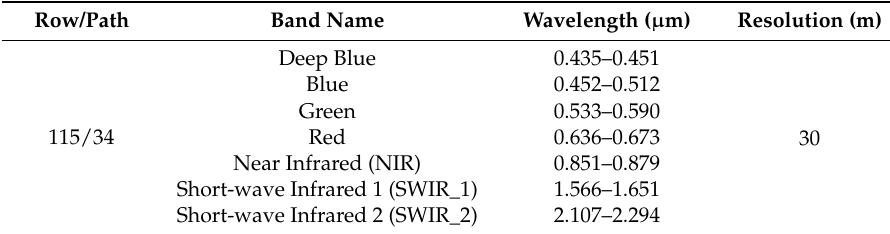
Table 2. Specifications of Landsat 8 OLI bands